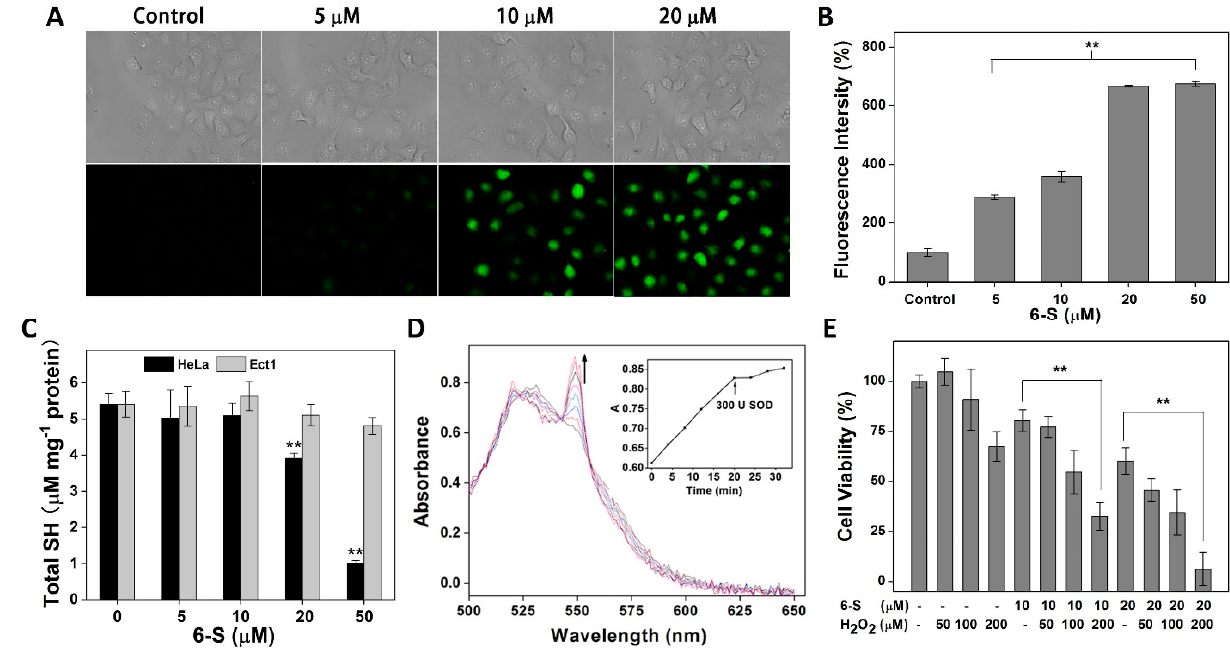
Figure 4. Induction of oxidative stress by 6-S. ( A ) The ROS level detected by DCFH-DA staining in HeLa cells. Phase-contrast (top) and fluorescence (bottom) images were acquired by inverted fluorescence microscopy. Scale bars: 20 µ m. ( B ) Detection of ROS with DCFH-DA in HeLa cells by Flow Cytometry. ( C ) Consumption of intracellular thiols by 6-S in HeLa cells and Etc1 cells. Free thiols in the total cell extract were quantified by DTNB titration. ( D ) Induction of superoxide anion production by 6-S-modified TrxR1. Superoxide anion generation was monitored by cytochrome C reduction assay. The inset shows a change in absorbance at 550 nm after adding cytochrome C and SOD. SOD was added at the time point indicated by the arrow in the inset. ( E ) Enhancement of H 2 O 2 cytotoxicity by 6-S. HeLa cells (1 × 10 4 ) were seeded on 96-well plates and allowed to attach for 24 h. Then, cells were pretreated with 6-S (10 or 20 µ M) for 4 h. After removing 6-S, the cells were further incubated with H 2 O 2 (50, 100, or 200 µ M) for 24 h. Cell viability was determined by MTT assay.